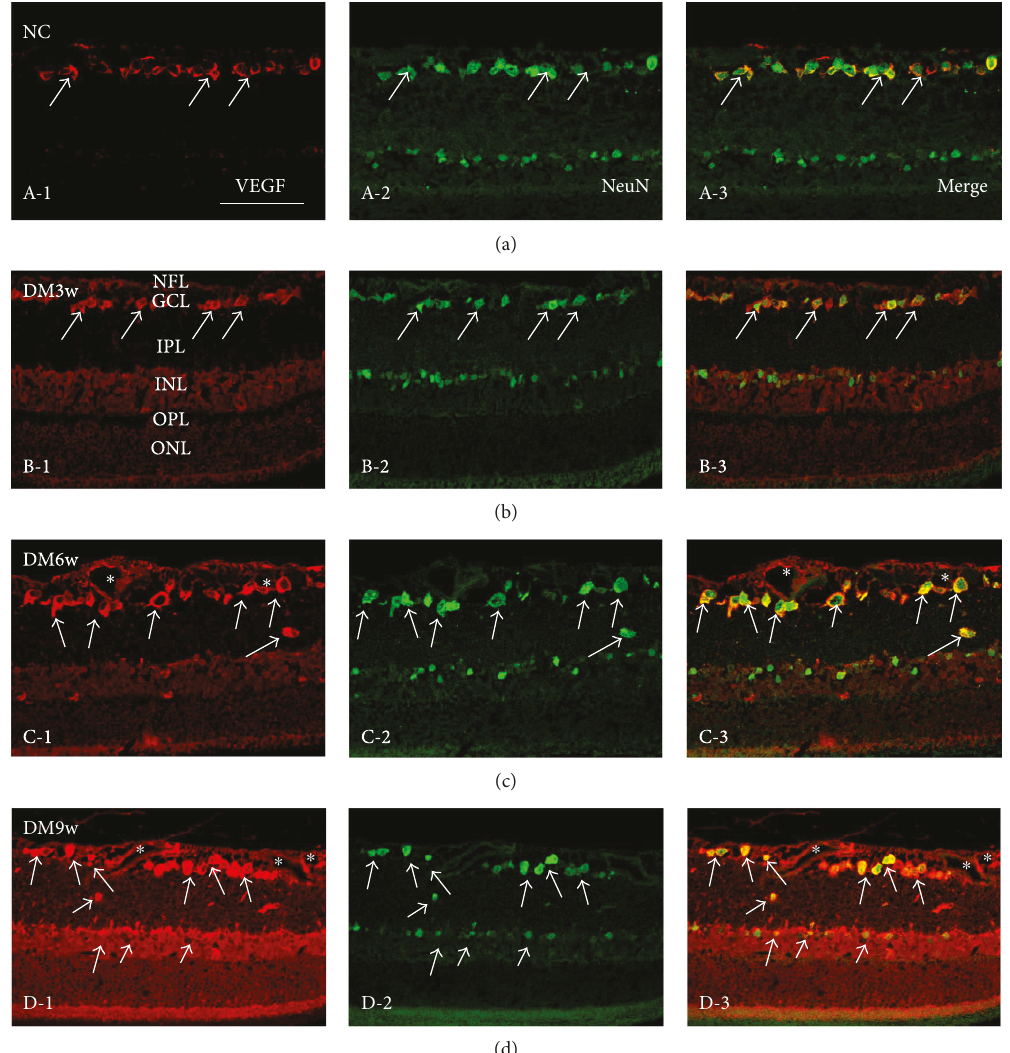
Figure 3: Representative photomicrographs of VEGF (red) and NeuN (green) double staining of the retina in the NC, DM3w, DM6w, and DM9w groups. VEGF immunoreactivity was localized in NeuN-labeled neurons (single arrow) and blood vessels (asterisk). VEGF staining appeared to be enhanced with the progress of diabetes (a, b, c, D-1), while the size of NeuN-labeled neurons became smaller (a, b, c, D-2). Bar=50 μ